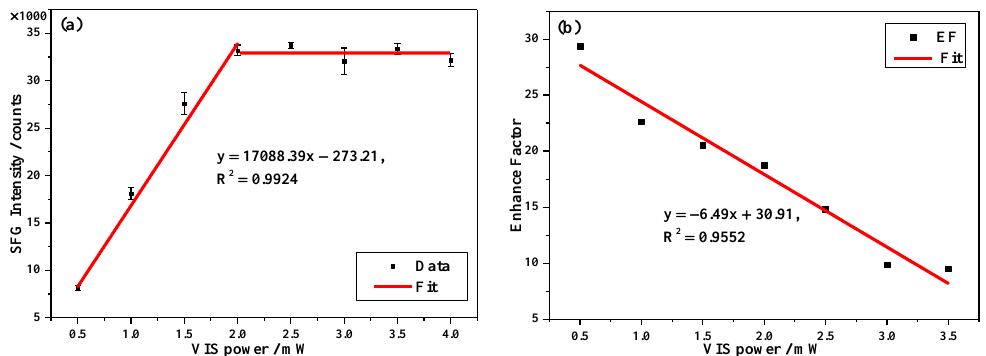
Figure 6. VIS power-dependent ( a ) SFG intensity of 4-MBN and ( b ) SFG enhancement factor of the Au NHAs at τ = 1 ps (with 5 mW IR and 60 s acquisition time).